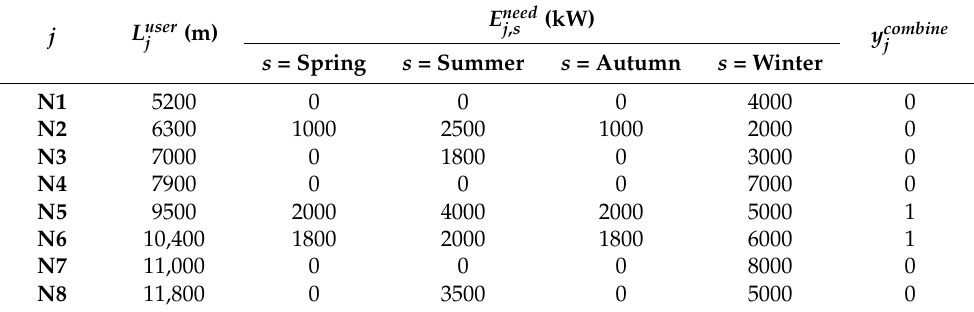
Table 2. The data of consumers.